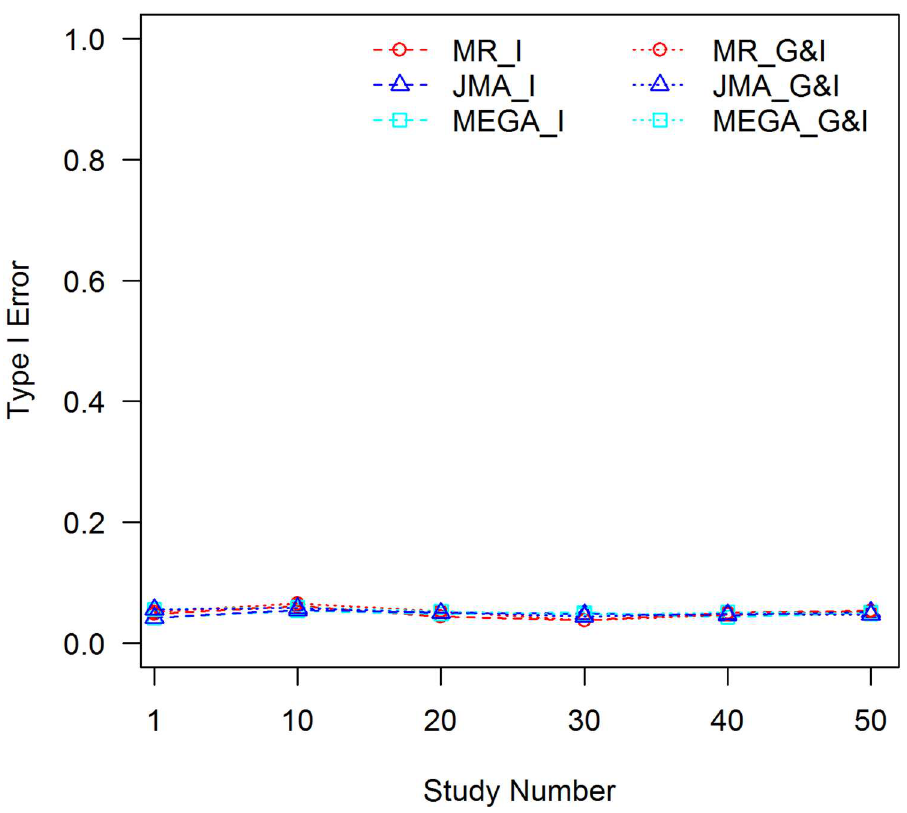
Fig 5. Tests of interaction with controlling for the C × E confounder, f 1 = 0.3, f 2 = 0.1. MR_I: MR test of interaction; MR_G&I: MR joint test of the geneticmain effect and interaction; JMA_I: JMA test of interaction; JMA_G&I: JMA joint test of the genetic main effect and interaction;MEGA_I: mega-analysis test of interaction; and MEGA_G&I: mega-analysis joint test of the genetic main effect and interaction.